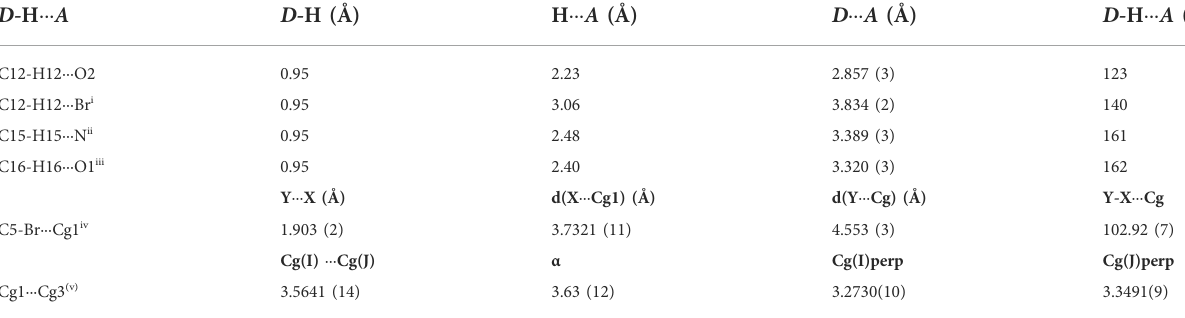
TABLE 3 Hydrogen bonds, Y-X...Cg interactions, π ··· π interactions parameters for isomaleimide 4. D -H ··· A D -H